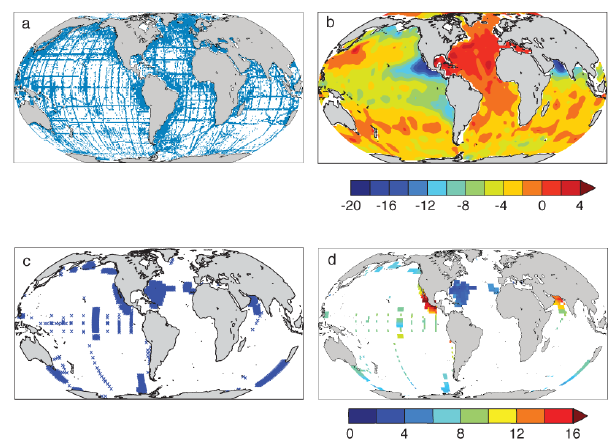
Fig. 1. (a) Locations of N ∗ data (all depths), (b) objectively mapped N ∗ (µM) for the depth interval 200–550m, (c) locations of δ 15 NO 3 data (all depths), and (d) δ 15 NO 3 concentrations (‰) averaged over the depth interval